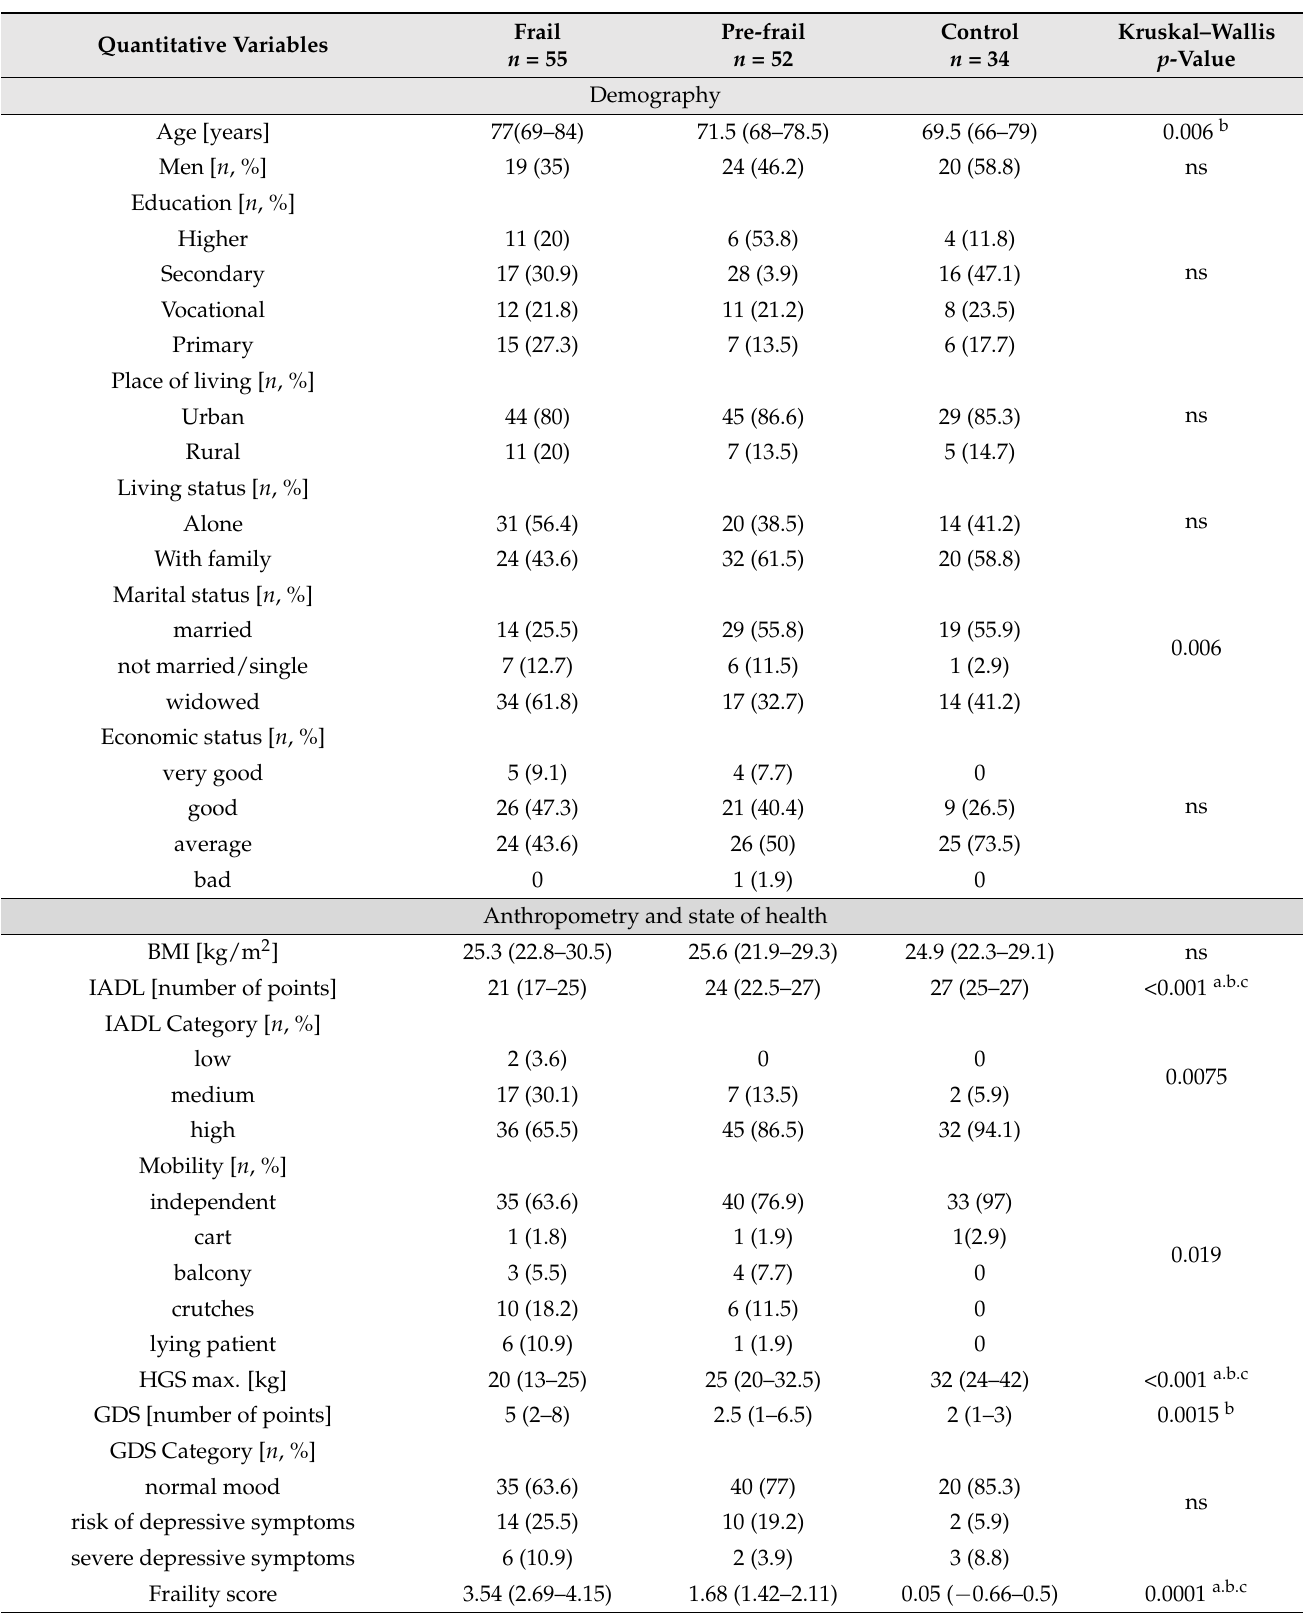
Table 2. Comparison of anthropometric variables, test results, and prevalence of chronic diseases between Frail, Pre-frail, and Control